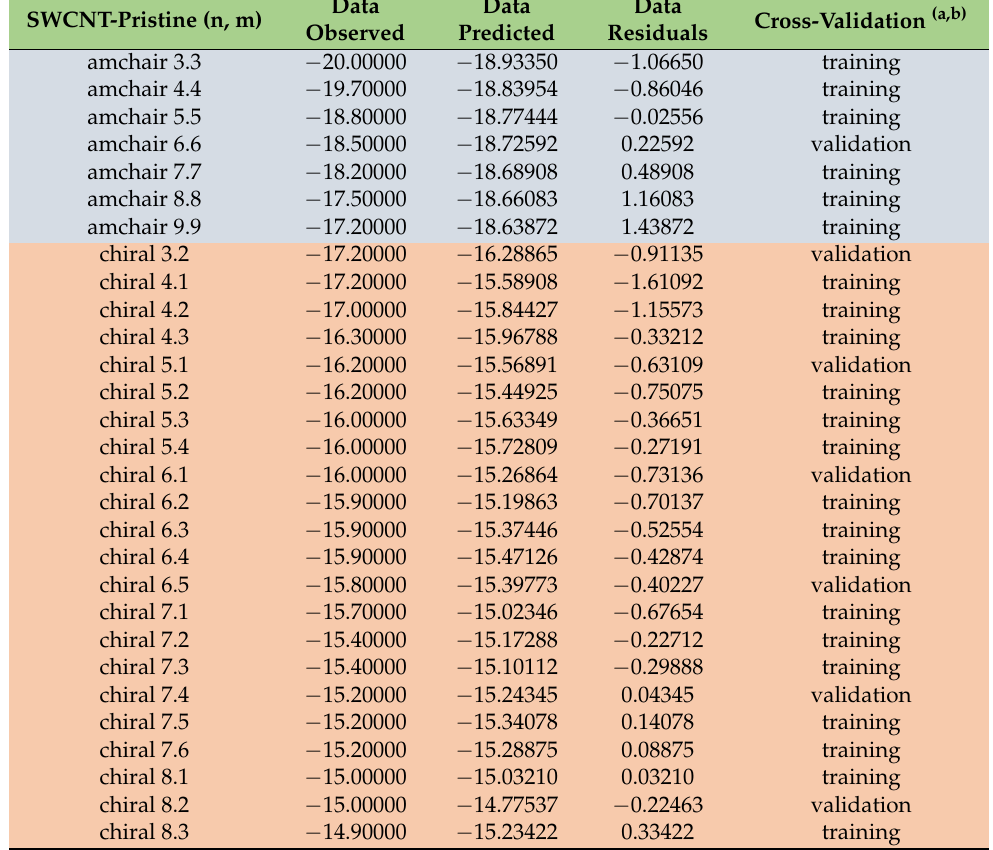
Table 1. Results of the Nano-QSTR regression model for mitochondrial F0-ATPase inhibition induced by